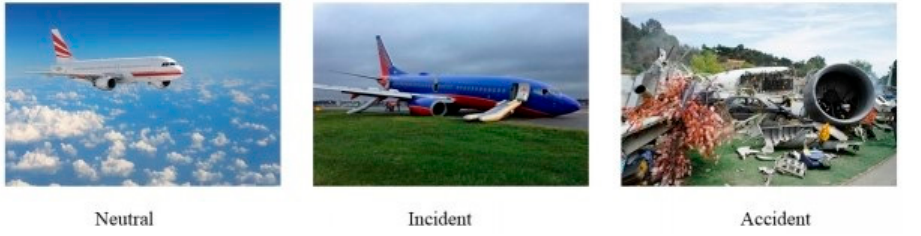
Figure 1. An example of materials for emotion elicitation.